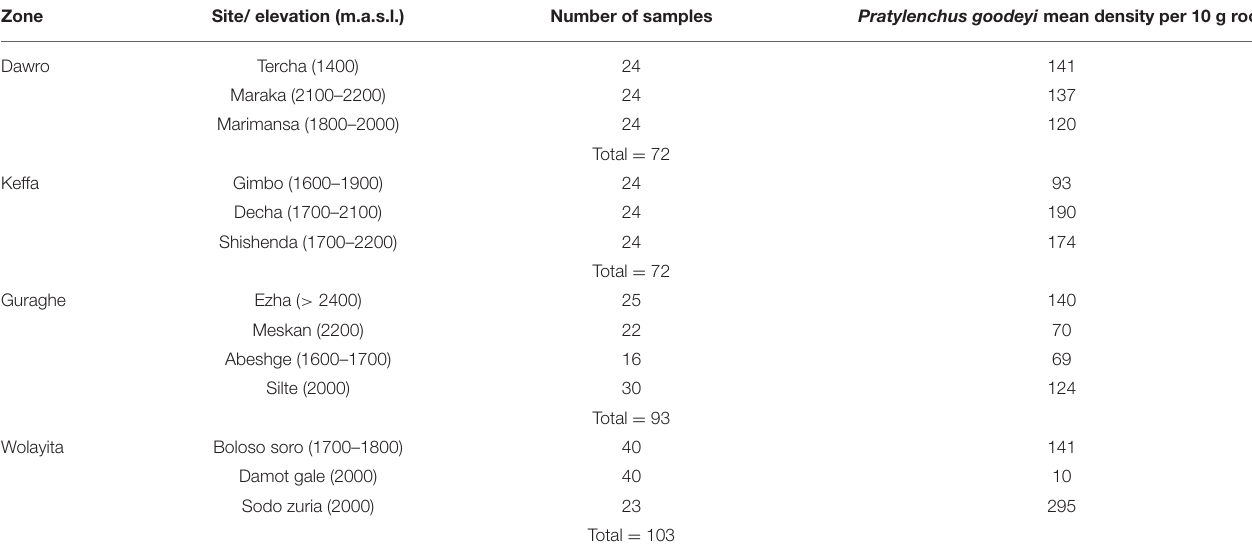
TABLE 1 | Pratylenchus goodeyi root density on enset sucker planting material collected from key enset production zones in Southern Ethiopia. Zone Site/ elevation (m.a.s.l.) Number of samples Pratylenchus goodeyi mean density per 10 g root Dawro Tercha (1400)